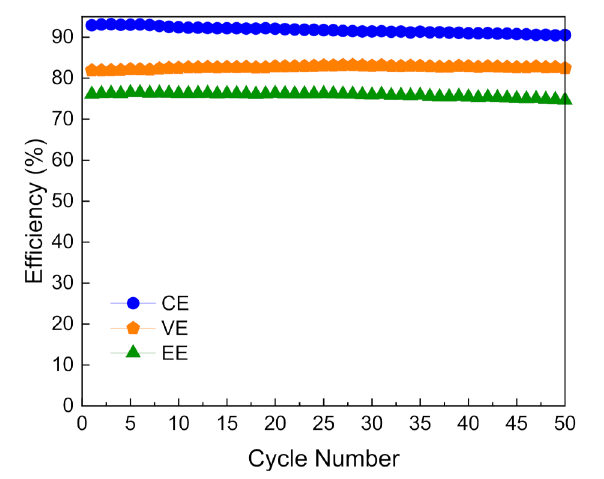
Figure 7. The cycling performance of a VFB with M3-300 membrane at the current density of 80 mA cm − 2 .